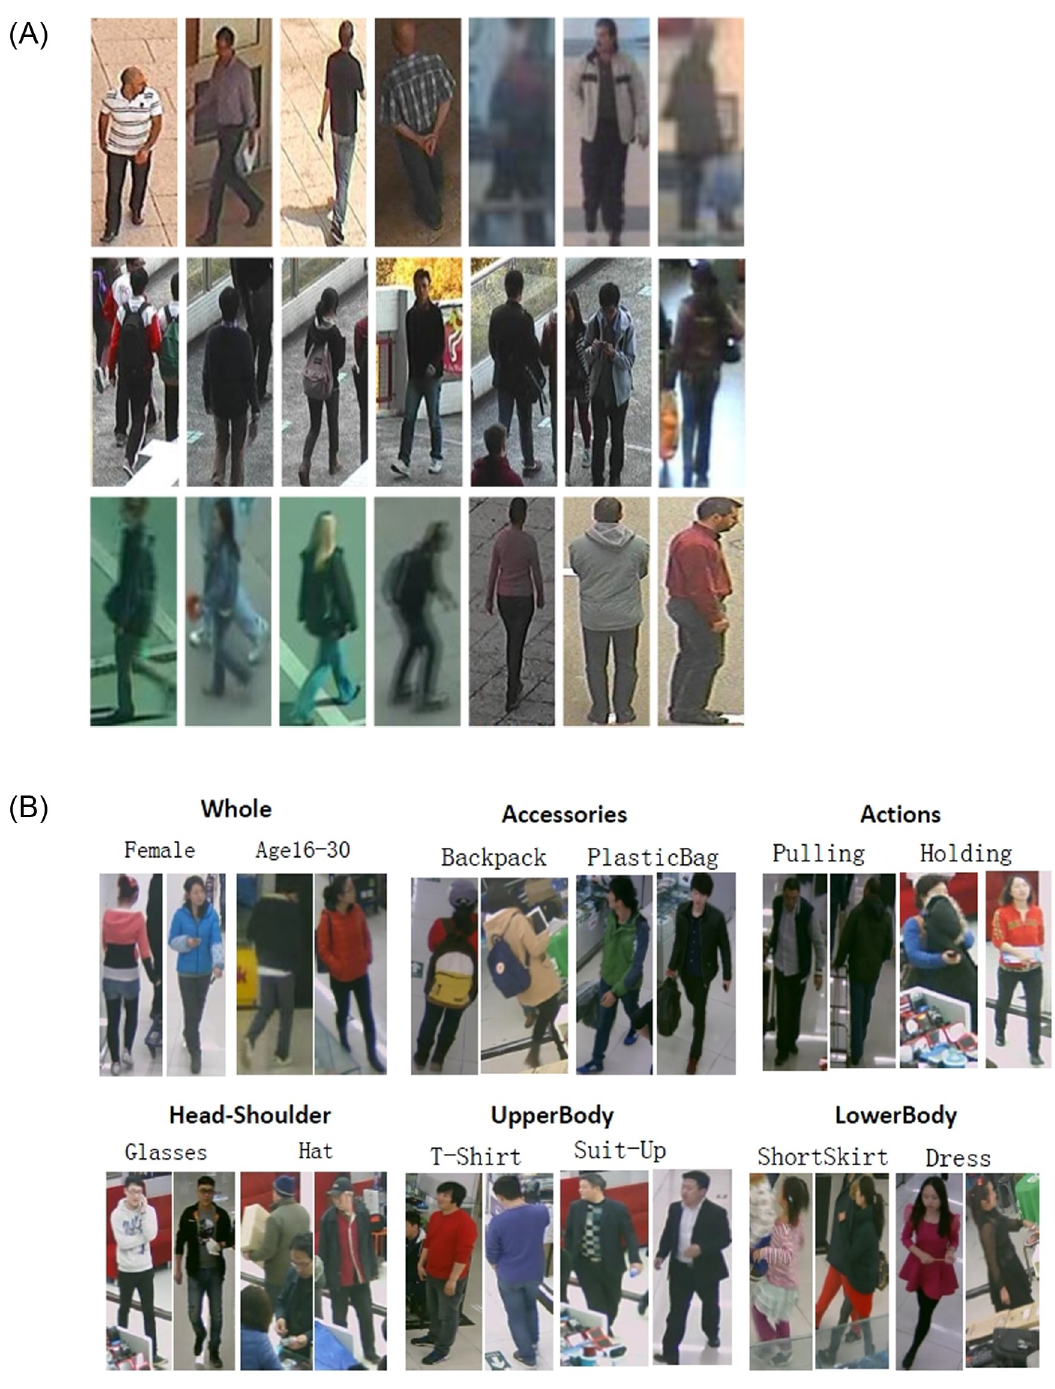
Fig 1. (a) PETA [4] dataset Samples. (b) RAP [5] dataset